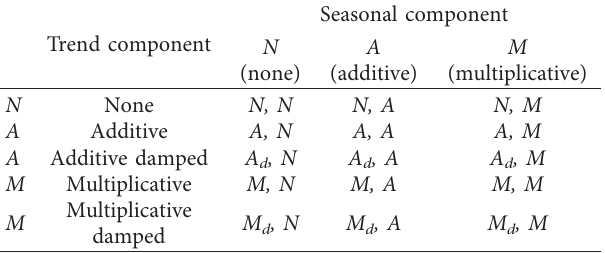
Table 2: The different types of ES Models